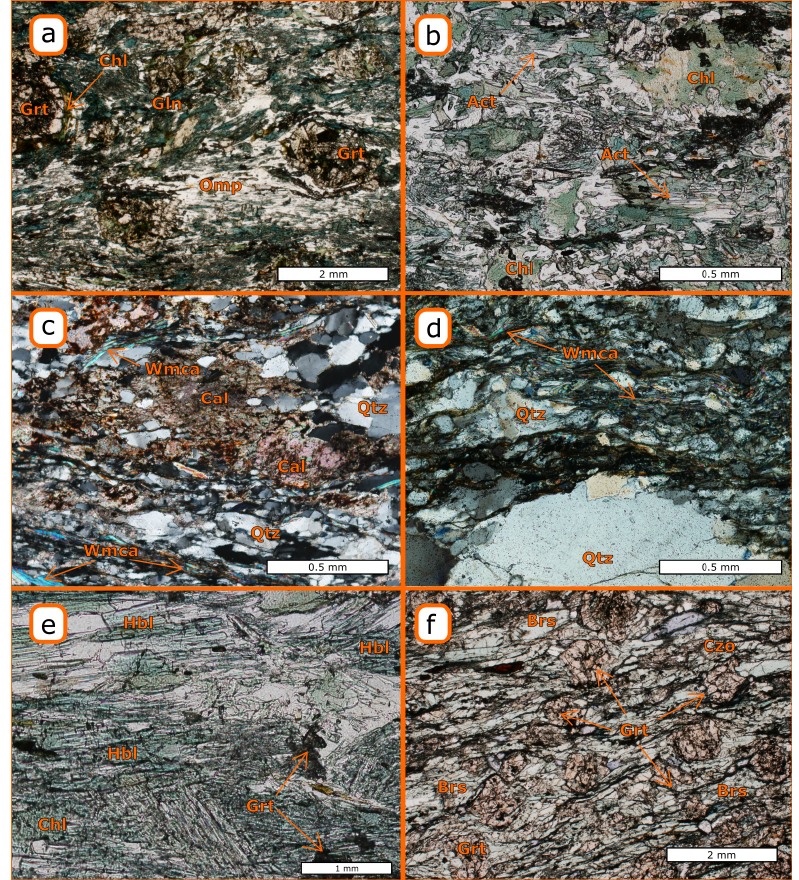
Figure 3. Thin-section photographs of typical microstructures in four representative samples. (a) Eclogite (MJS17) with foliation of glau- cophane (Gln) and omphacite (Omp) flowing around larger grains of garnet (Grt) with some retrograde chlorite (Chl) visible at its rim. (b) Greenschist (MJS36) with actinolite (Act) and chlorite (Chl) visible in the foliation and larger chlorite grains found unoriented grown over the foliation. (c) Calcareous micaschist (MJS20) with quartz (Qz), calcite (Calc) and white mica (Wmca) oriented in the foliation. (d) Gneiss (MJS35) displaying strongly foliated fine grained quartz (Qz) and white mica (Wmca) larger coarse grained quartz. (e) Amphi- bolite (MJS26) displaying abundant hornblende (Hbl) with some chlorite (Chl) and smaller fragmented garnet (Grt) grains. (f) Garnet (Grt) rich band in the blueschist (MJS36) surrounded by barroisite (Brs) and clinozoisite (Czo). Sections are oriented perpendicular to the foliation and parallel to the stretching lineation. Panels (a) , (b) , (e) and (f) are shown under plane-polarized light, while (c) and (d) are shown under x -polarized light. For sample descriptions see Table